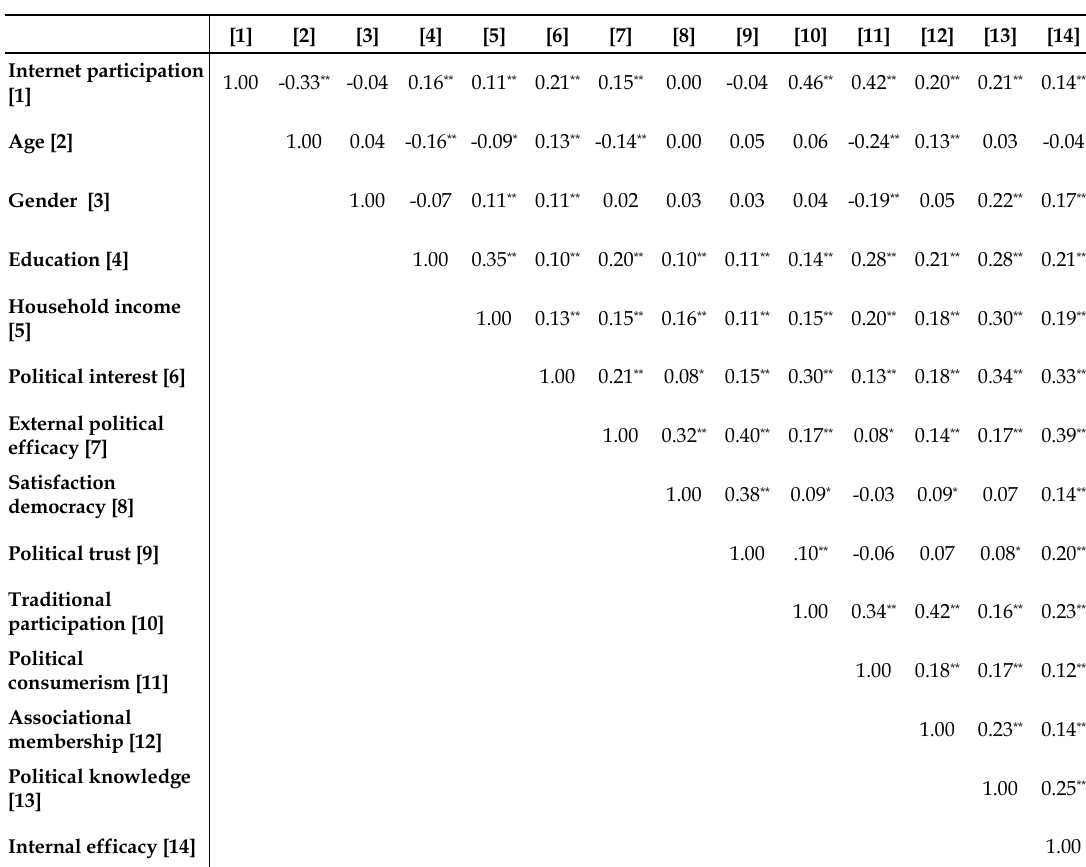
Table 1: Correlation